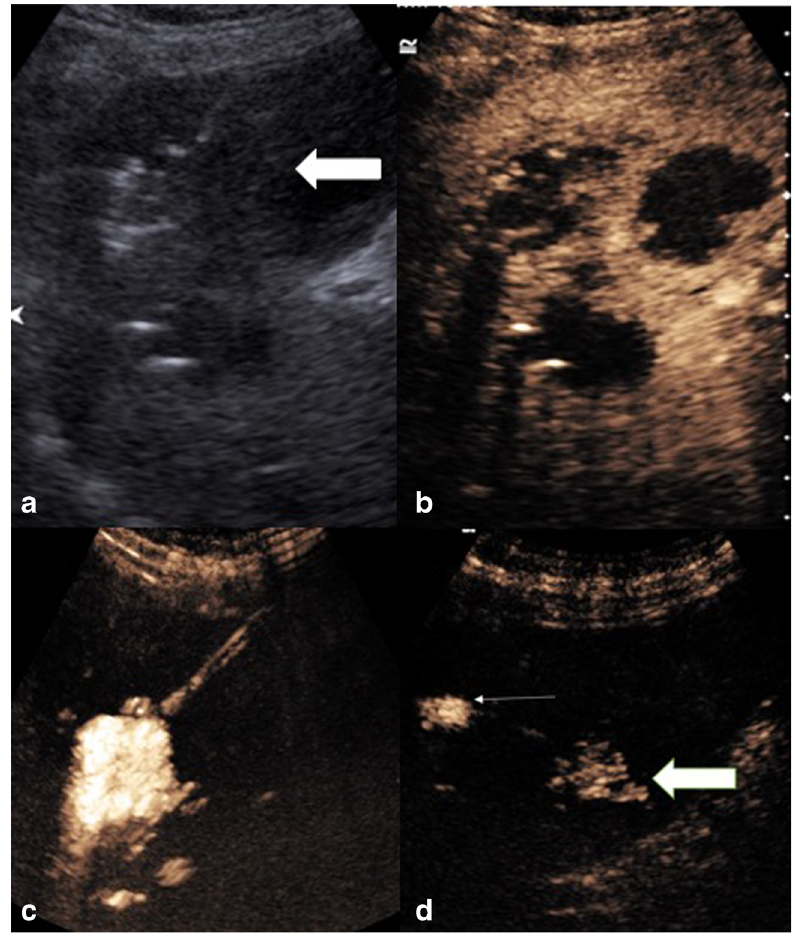
Fig. 2 (A) Greyscale imaging of the left lobe ofthe liverwith an ill- defined lesion (large arrow), containing locules of gas. (B) Following administration of intravenous ultrasound contrast the non-enhancing liver abscess with multiple locules is clearly seen. (C and D) Dilute ultrasound contrast injected via an in-dwelling catheter within one locule, confirms correct placement and confirms connections between multiple locules (thin and thick